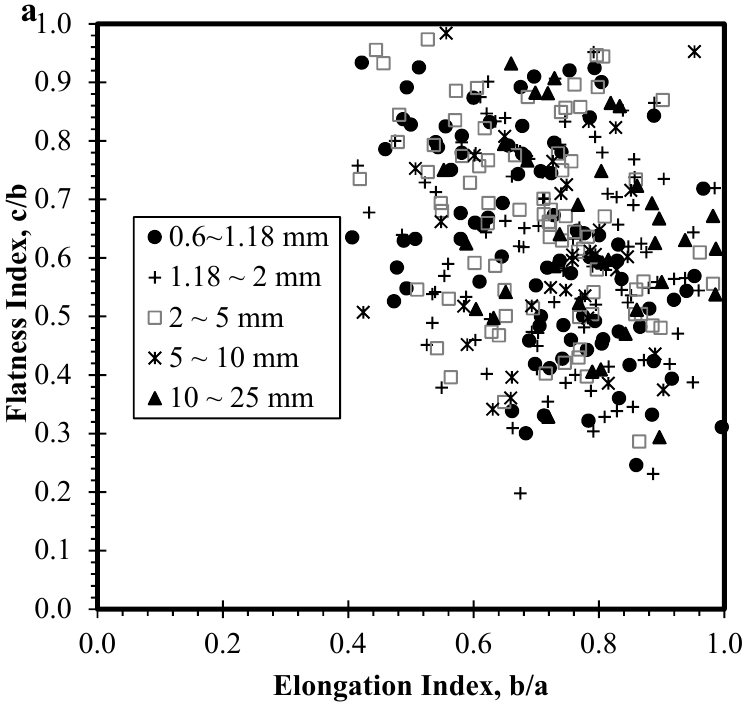
b Figure 4. Cont